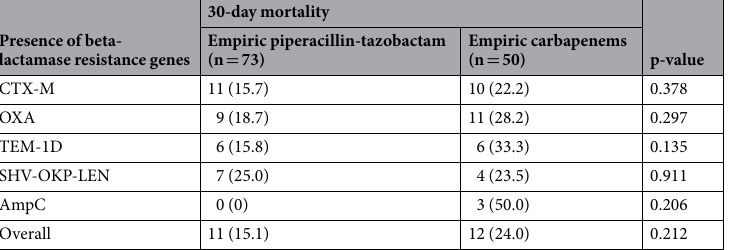
Presence of beta- lactamase resistance genes